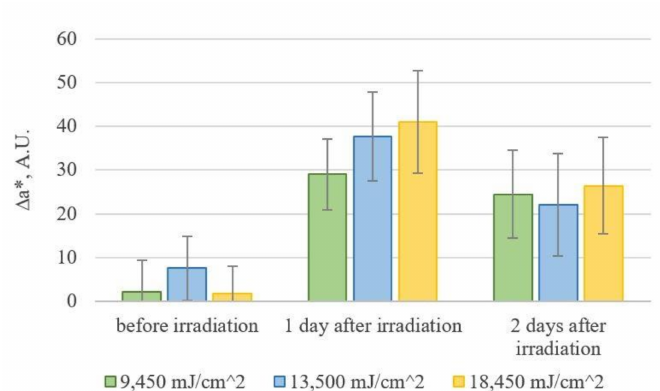
Figure 5. Dynamics of mean values of ∆ a* changes by group.